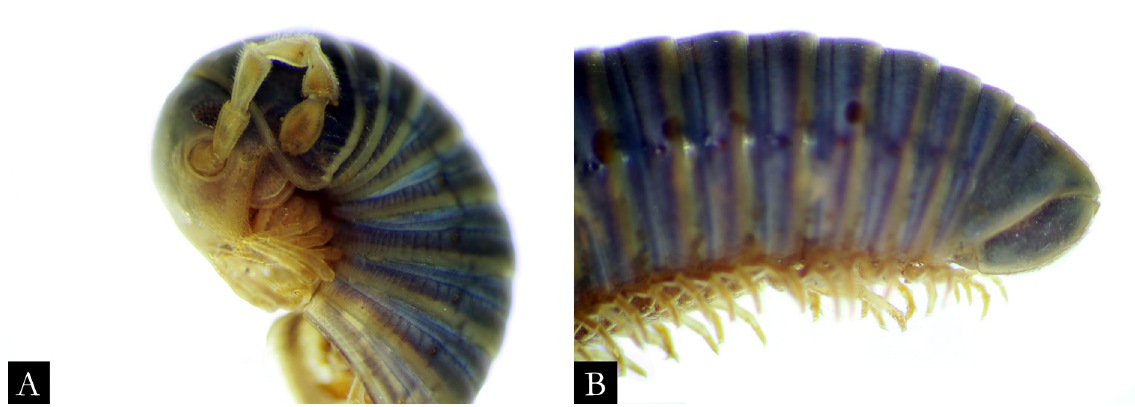
Fig. 62. Pseudonannolene centralis Silvestri, 1902, syntype, ♂ (USNM 2033), in lateral view. A . Anterior region. B . Posterior region. Images not to